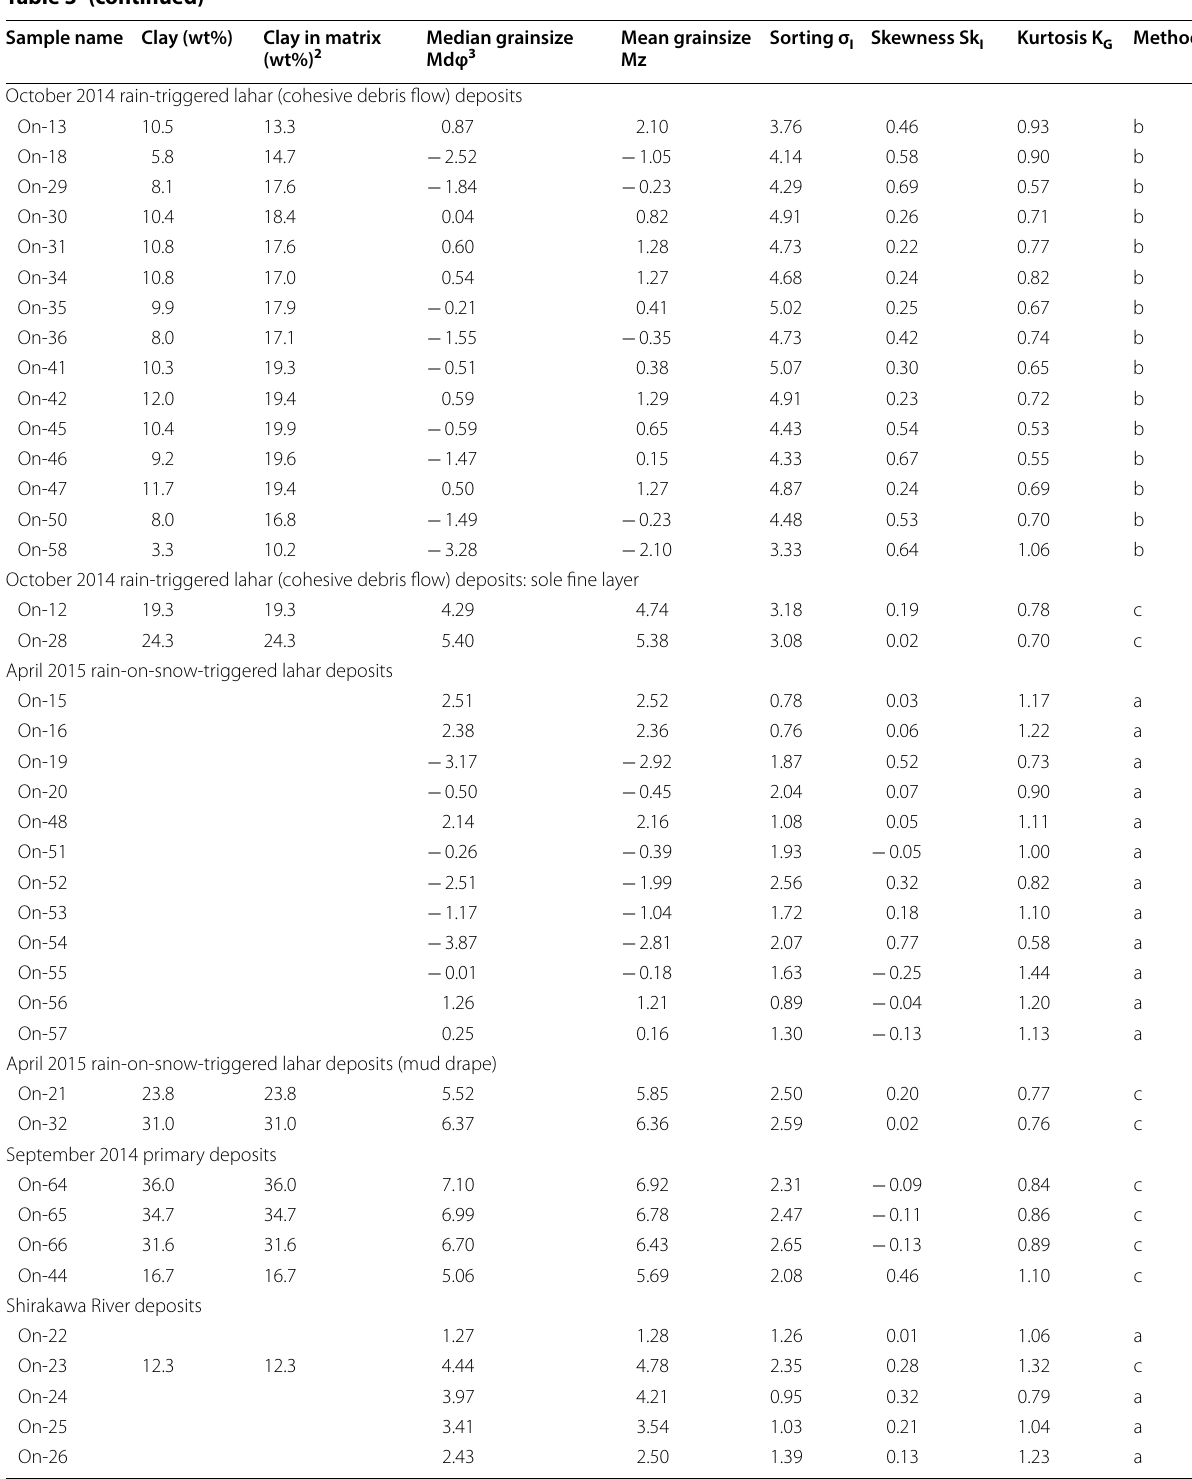
1 Silt indicates particles of < 0.063 mm when manual sieving methods